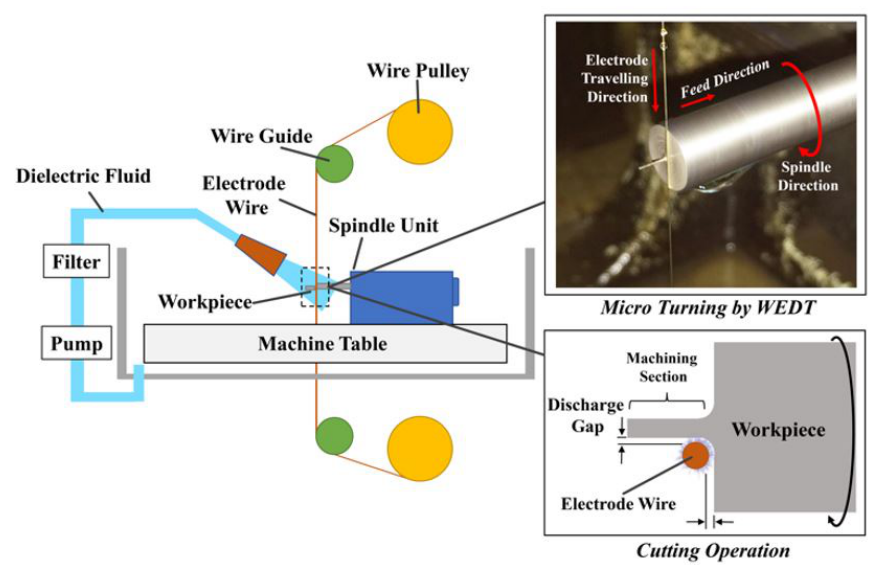
Fig. 2. Schematic representation of experimental setup and cutting operation